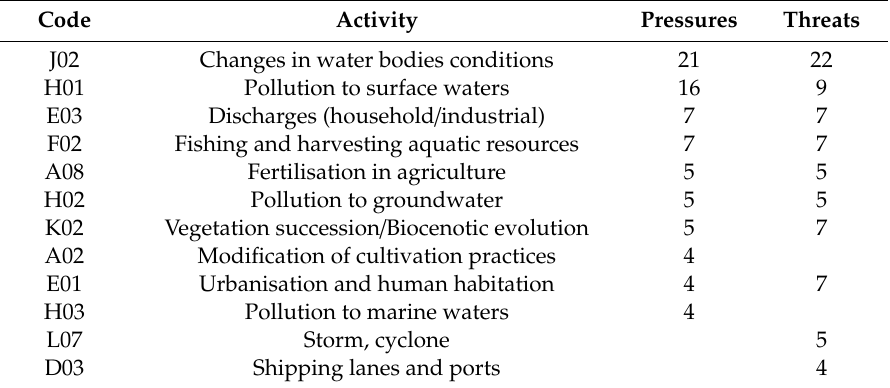
Table 2. Activities with highly important pressures and threats on “coastal lagoons” habitats throughout the EU. The “Pressures” and “Threats” columns show the number of Member States that have reported these activities as the ten most impacting (modified from the global report for the 2007–2012 reporting period for coastal lagoons